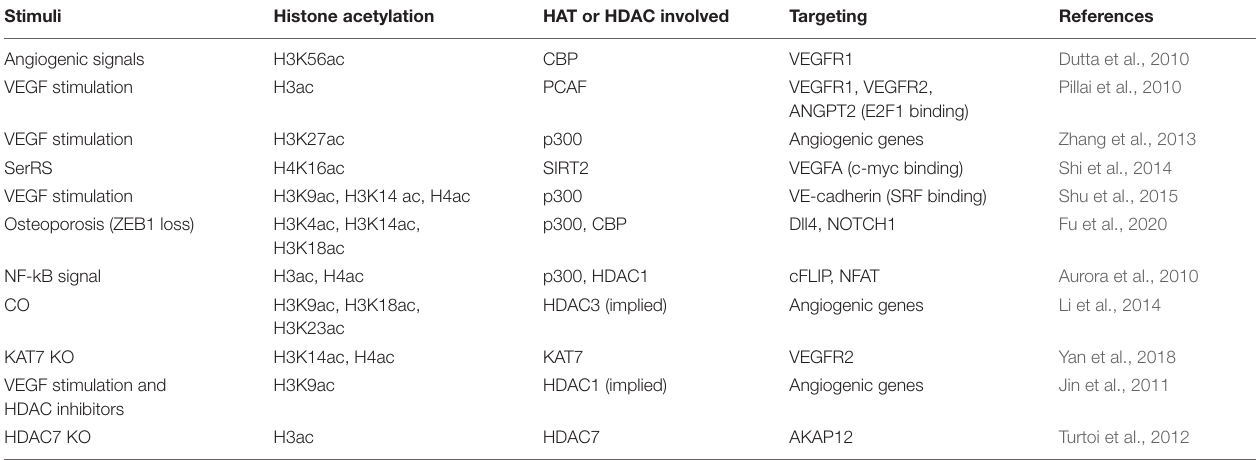
TABLE 4 | Histone acetylation associated with angiogenesis.